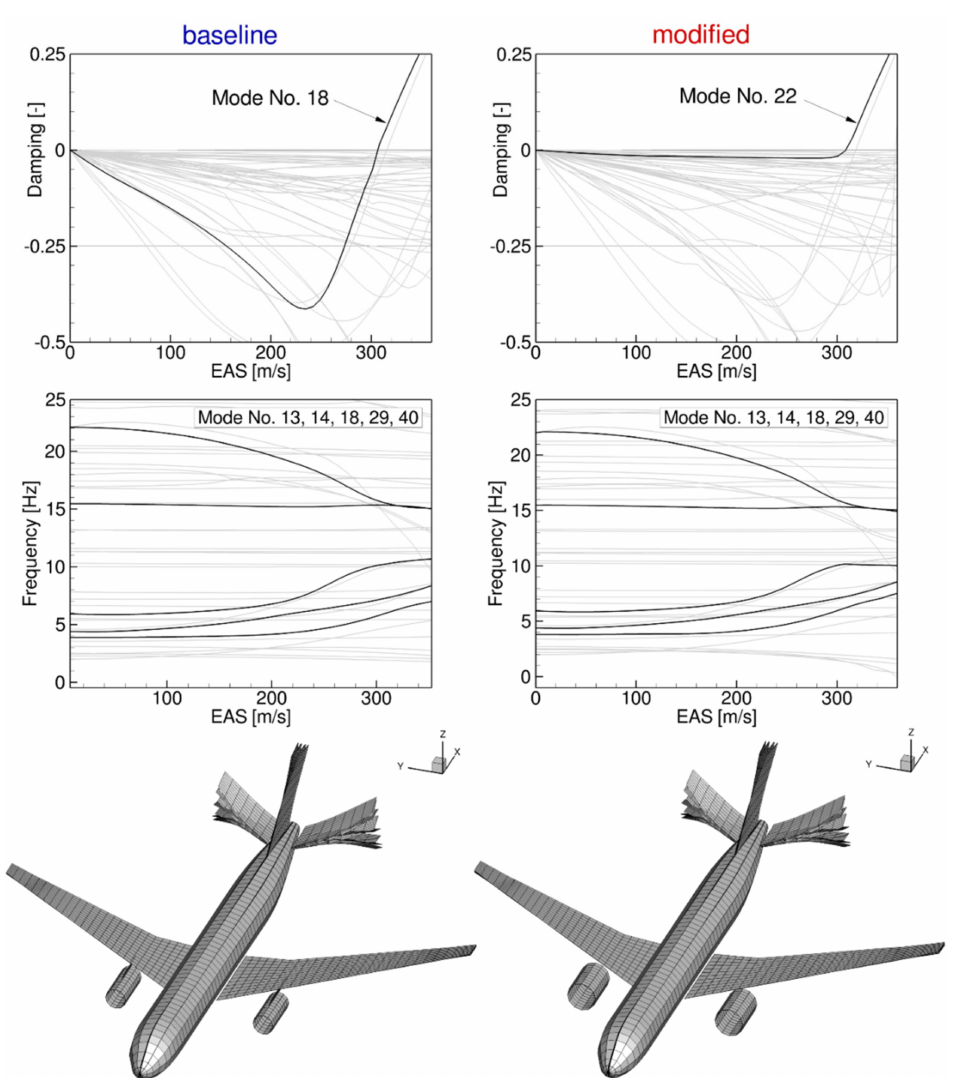
Figure 16. Damping, frequency, and flutter mode of the most critical mass case (MOOee) for the baseline ( left ) and the modified configuration ( right